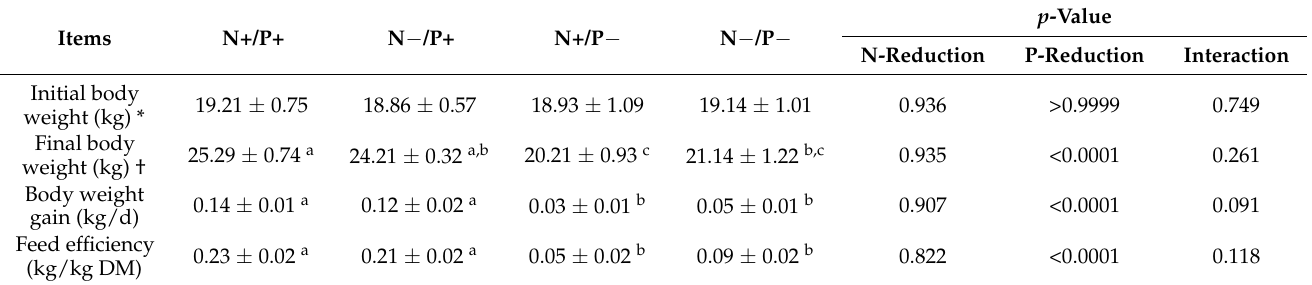
Table 2. Initial body weight and effects on body weight gain, final body weight, and feed efficiency of young goats fed an N- and/or P-reduced